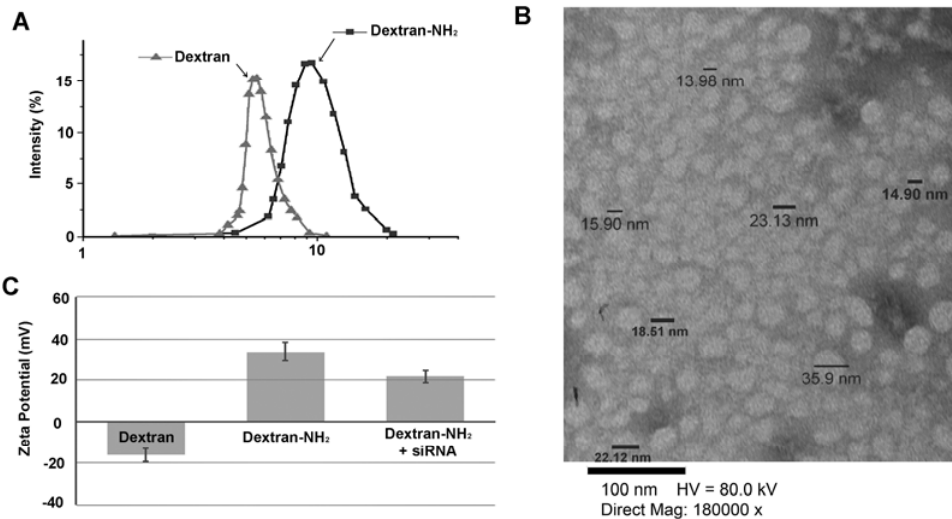
Figure 1. ( A ) Hydrodynamic radius of dextran and amino ‐ dextran dextran from intensity ‐ based distributions. ( B ) Transmission electron microscopy (TEM) image of amino ‐ dextran. Negative staining with phosphotungstic acid (PTA), scale bar is 100 nm. ( C ) Zeta potential of dextran and amino ‐ dextran dextran. n = 3, values represent Mean ± standard deviation (SD).